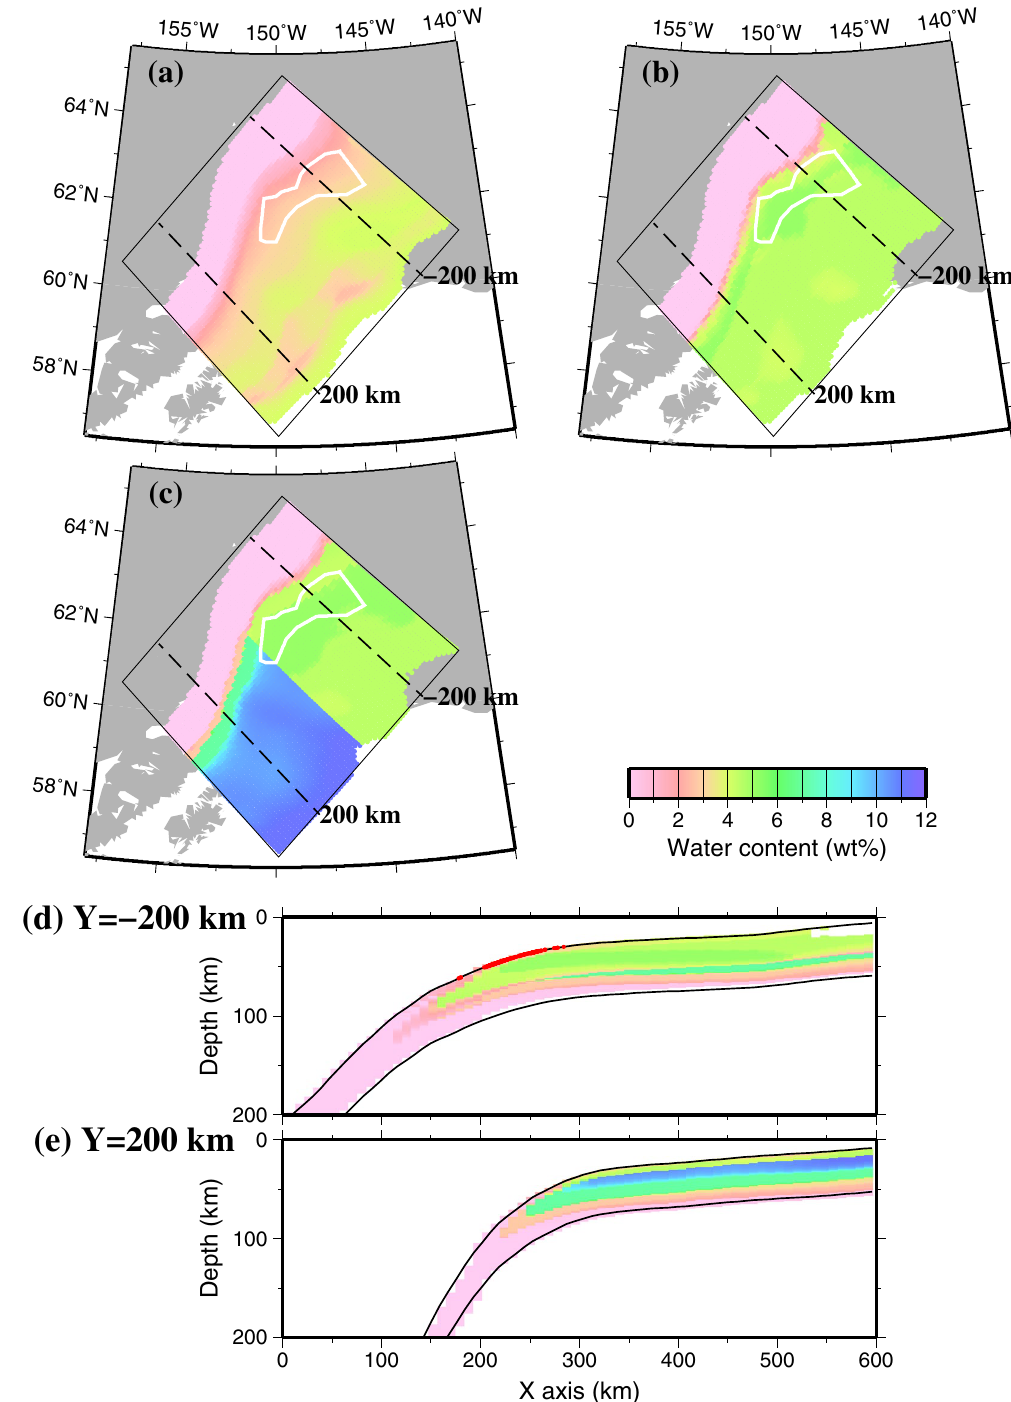
Figure 3. Water content distribution in the slab at present (0 Ma). The thin black box represents the model region. The water content distribution is plotted only in the region where the depth of the slab surface is shallower than the bottom of the model (200 km) and where the temperature is higher than 200 °C, for which values of phase diagram data exist. The white line indicates the area where tectonic tremors occur, as shown in Fig. 1, and the black dashed lines indicate the location of profile Y = − 200 km and Y = 200 km. ( a ) The slab surface (0 km). ( b ) 6 km depth from the slab surface. ( c ) 10 km depth from the slab surface. ( d ) The vertical cross section along profile Y = − 200 km. The water content distribution is plotted only in the region where the temperature is higher than 200 °C, for which values of phase diagram data exist. The two solid black lines represent the top and bottom surfaces of the slab. The red solid circles represent the hypocentres of tectonic tremors within a one-sided width of 1 km. ( e ) Same as ( d ) except the vertical cross section along profile Y = 200 km. The map was created by using the Generic Mapping Tools (GMT) 25 (version: GMT 4.5.7, URL link: https:// www. gener ic- mappi ng- tools. org/ downl